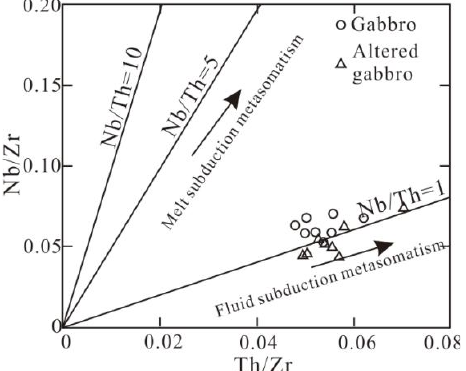
Figure 8. Th/Zr versus Nb/Zr discrimination diagram for Ping’an gabbros.